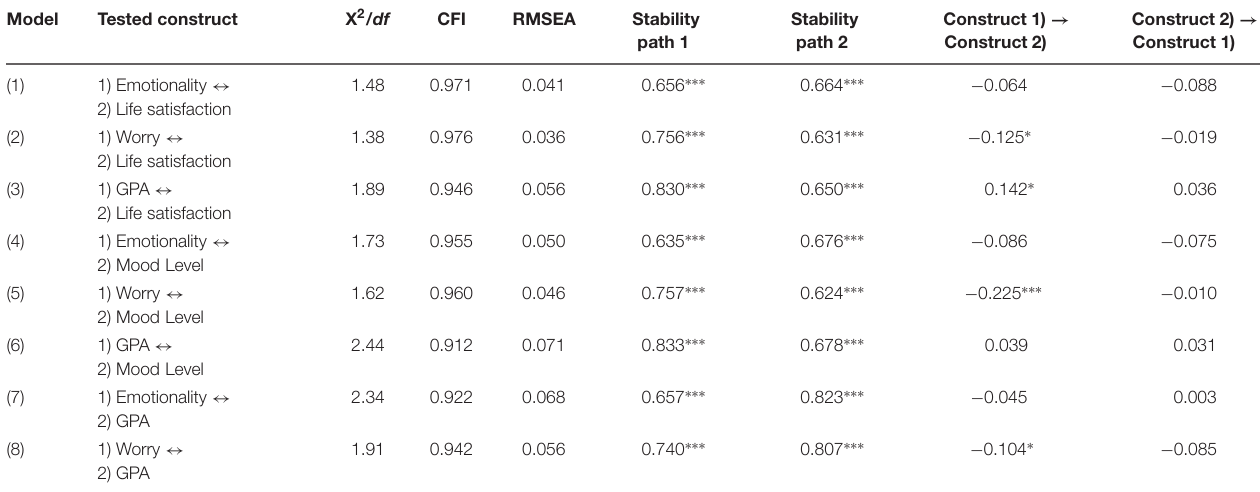
point 1 did not predict change in Emotionality (Model